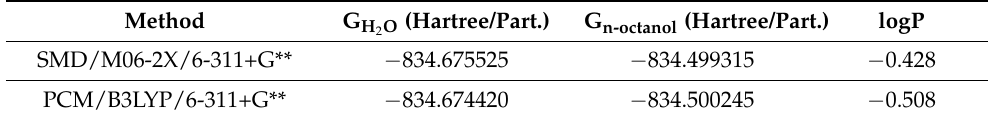
Table 2. Gibbs free energies (G) in water and n-octanol were obtained as a result of DFT simulations and on their basis, determined partition coefficient (logP) values.